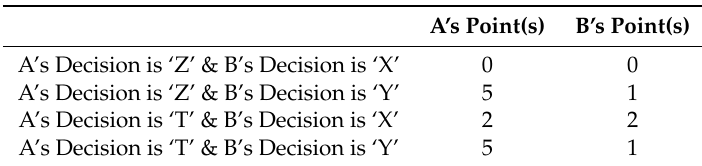
Table A1. Payoff